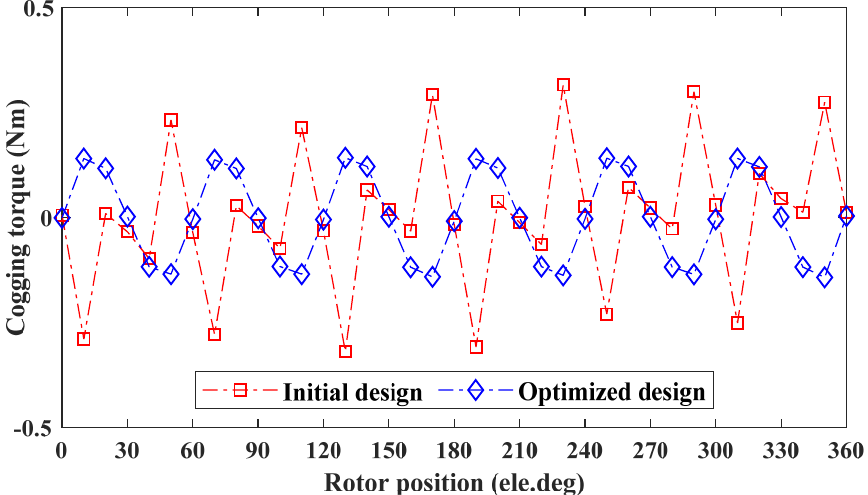
Figure 13. Cogging torque analysis of initial and optimized design.